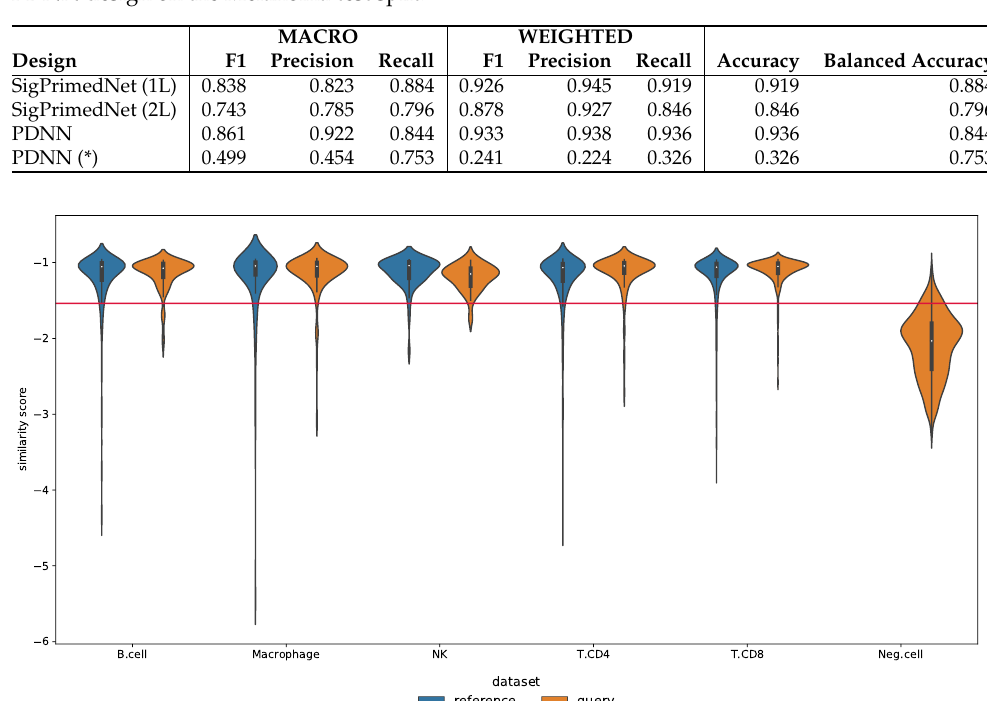
Figure 9. Similarity score distribution for each cell type on the validation and test splits Melanoma dataset). The horizontal line shows the threshold obtained using the reference set inner splits as detailed in Section